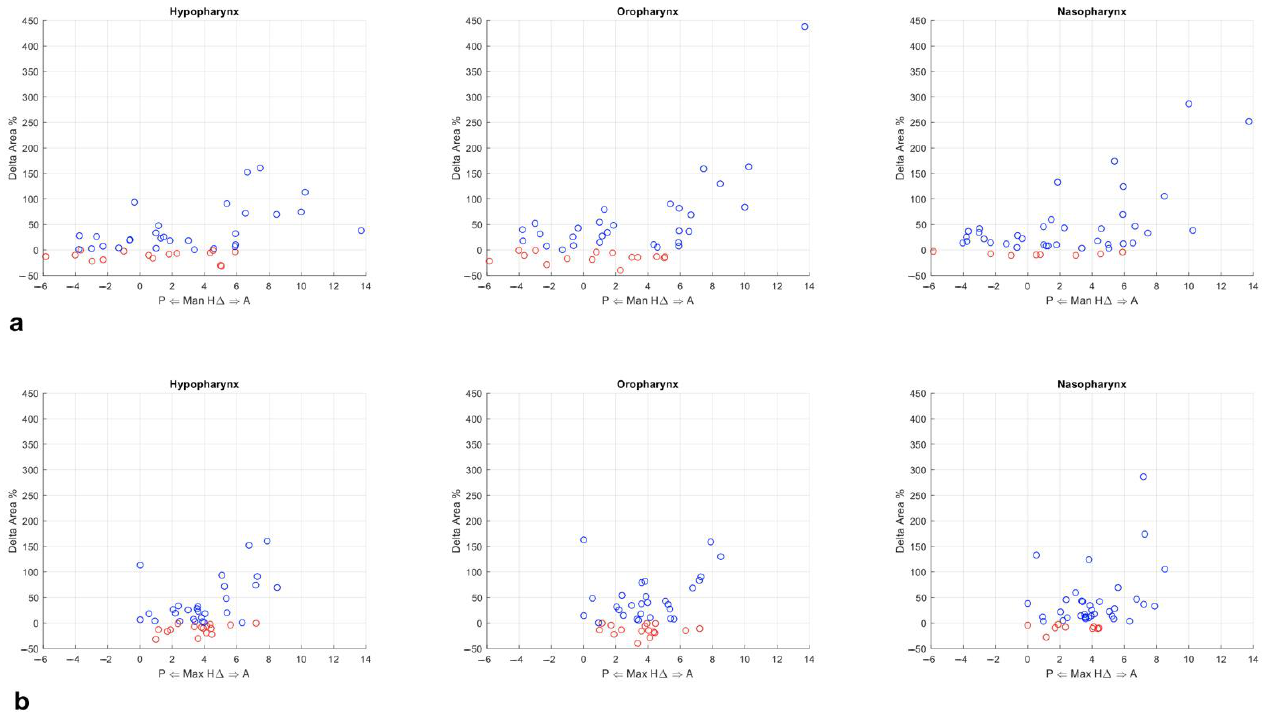
Figure 4. Plotted data of upper airways (UA) ∆Area variation in relation to maxillary bones displacement. ( a ) The X axis reports the maxillary antero–posterior repositioning (AP) movement, while the Y -axis reports the average percentage ∆Area variation of the slices of the corresponding patient for each subregion. Red circles indicate an average percentage reduction in area while blue circles indicate an average increase. ( b ) The X axis reports the mandibular AP movement, while the Y -axis reports the average percentage ∆Area variation of the slices of the corresponding patient for each subregion. Red circles indicate an average percentage reduction in area while blue circles indicate an average increase.